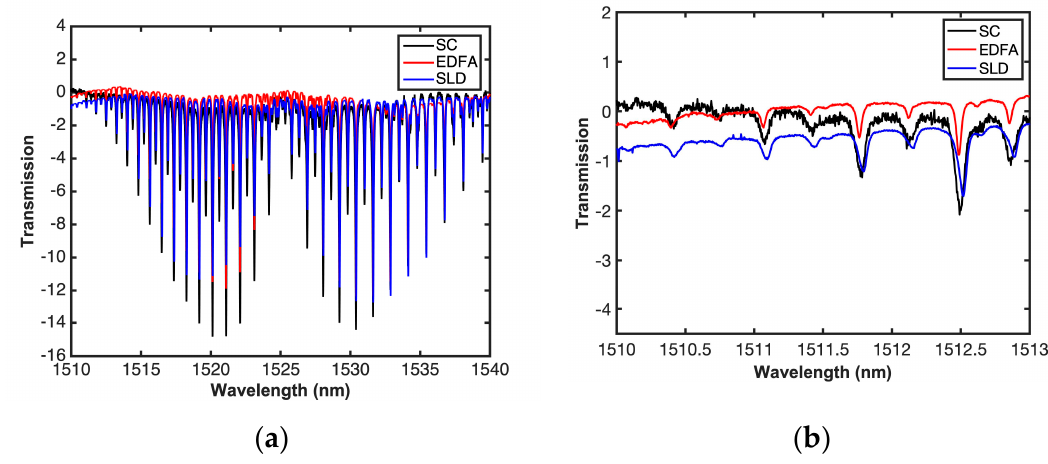
Figure 6. ( a ) Gas transmission with SC, SLD, EDFA, and ( b ) magnified view of 1510–1513 nm region.